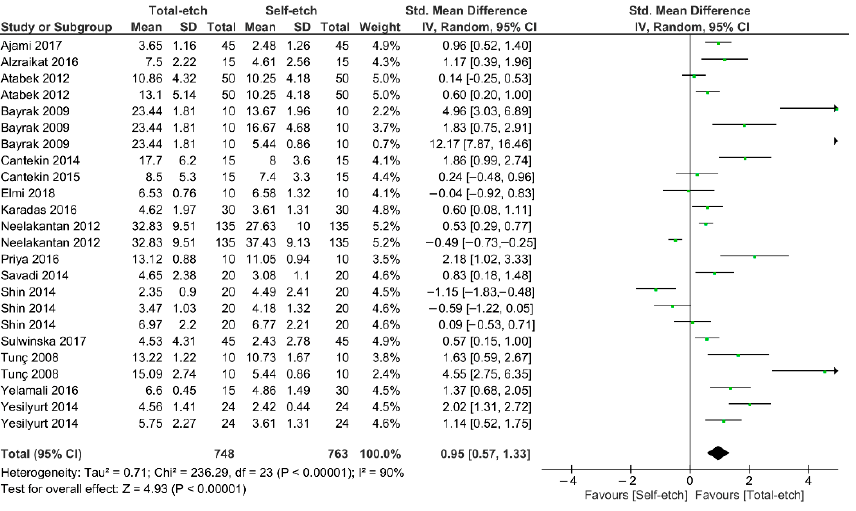
Figure 3. Findings of the meta-analysis of the bond strength of resin-based materials to Biodentine™ calcium silicate-based cement. Bond strength was similar between both strategies ( p = 0.12). Figure 4 shows the meta-analysis of the bond strength values of resin composite materials to TheraCal LC ® cement. According to the analysis, the bond strength was higher for the total-etch technique ( p = 0.02). A high heterogenicity (95%) among the studies was observed. Figure 4. Findings of the meta-analysis of the bond strength of resin-based materials to TheraCal LC ® calcium silicate-based cement. Bond strength was higher for the total-etch technique ( p = 0.02). The risk of bias in the articles studied in this review is recapped in Table 2. Most of the articles included failed to meet the parameters of Single Operator, Blinded Operator, Sample Size Calculation, and Control group. The global analysis showed that the utmost of the articles included were cataloged as high and medium risk of bias.